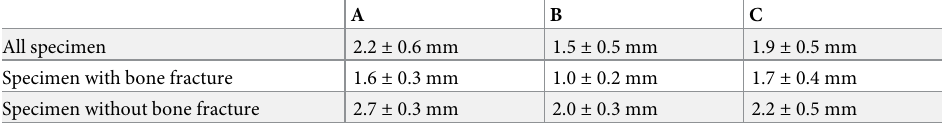
Table 1. Measurement results of the cortical thickness of the mandible for all specimen (mean ± standard deviation). A B C All specimen 2.2 ± 0.6 mm 1.5 ± 0.5 mm 1.9 ± 0.5 mm Specimen with bone fracture 1.6 ± 0.3 mm 1.0 ± 0.2 mm 1.7 ± 0.4 mm Specimen without bone fracture 2.7 ± 0.3 mm 2.0 ± 0.3 mm 2.2 ± 0.5 mm Measurement locations A, B and C can be seen in Fig